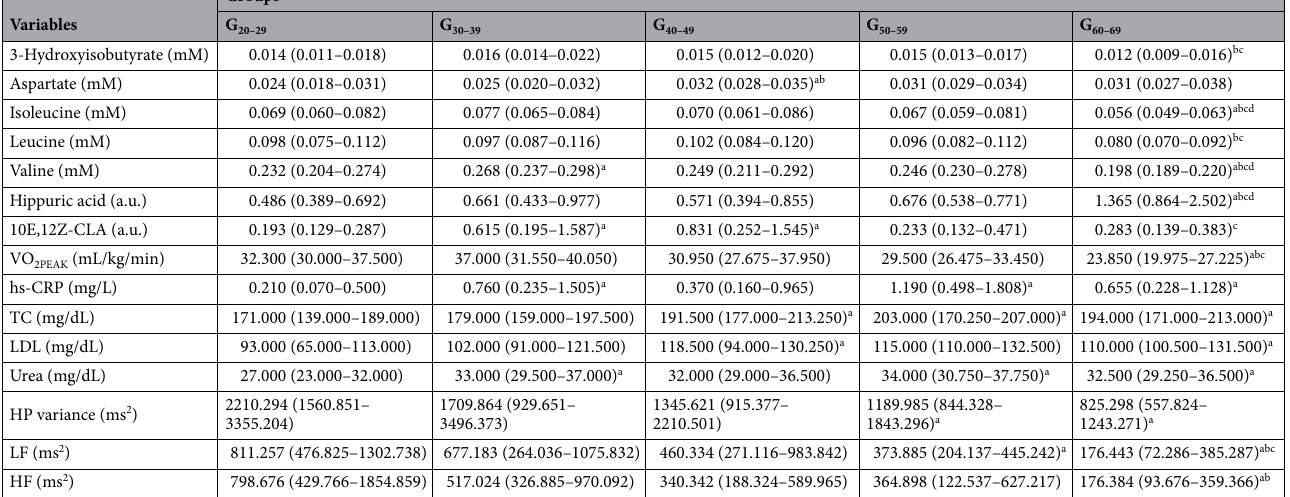
Table 2. Significant autonomic, metabolomic, and cardiorespiratory fitness variables across age groups. Data presented in median and interquartile interval. Logarithm (for hippuric acid, 10E,12Z-CLA, isoleucine, 3-Hydroxyisobutyrate, leucine, HP Variance, LF, and HF), cubic root (for hs-CRP), quadratic (for TC), and inverse (for valine) transformations were used in the statistics. The variables not listed above were used